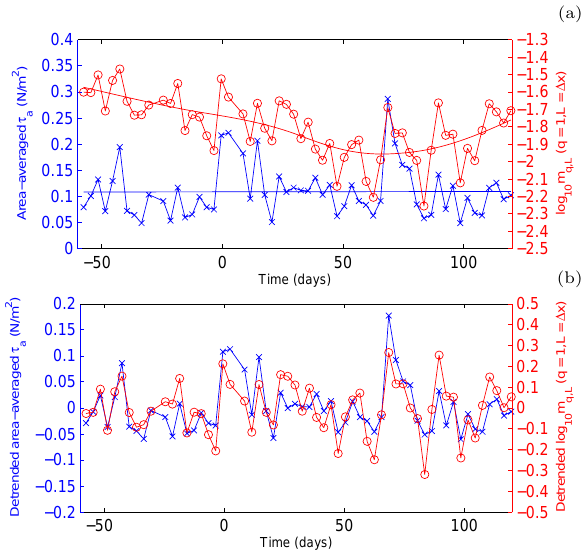
Fig. 3. Time series of ¯ τ a (Nm − 2 ) and ˜ m q,L (for q = 1 and L = 1x ) in the 1999/2000 winter: original data with trend lines (a) and detrended data (b) . Time is shown in days after 1 January 2000. See Supplement Fig. 1 for other winter